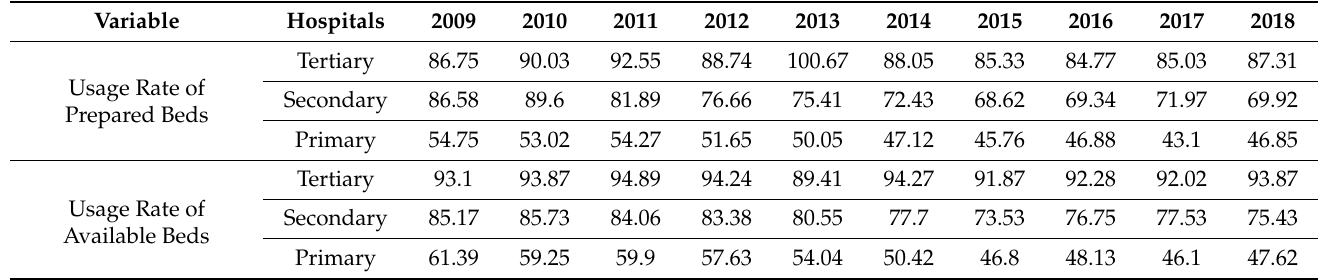
Table 13. The usage rate of prepared beds and available beds of different level public hospitals in Beijing from 2009 to 2018 (%).